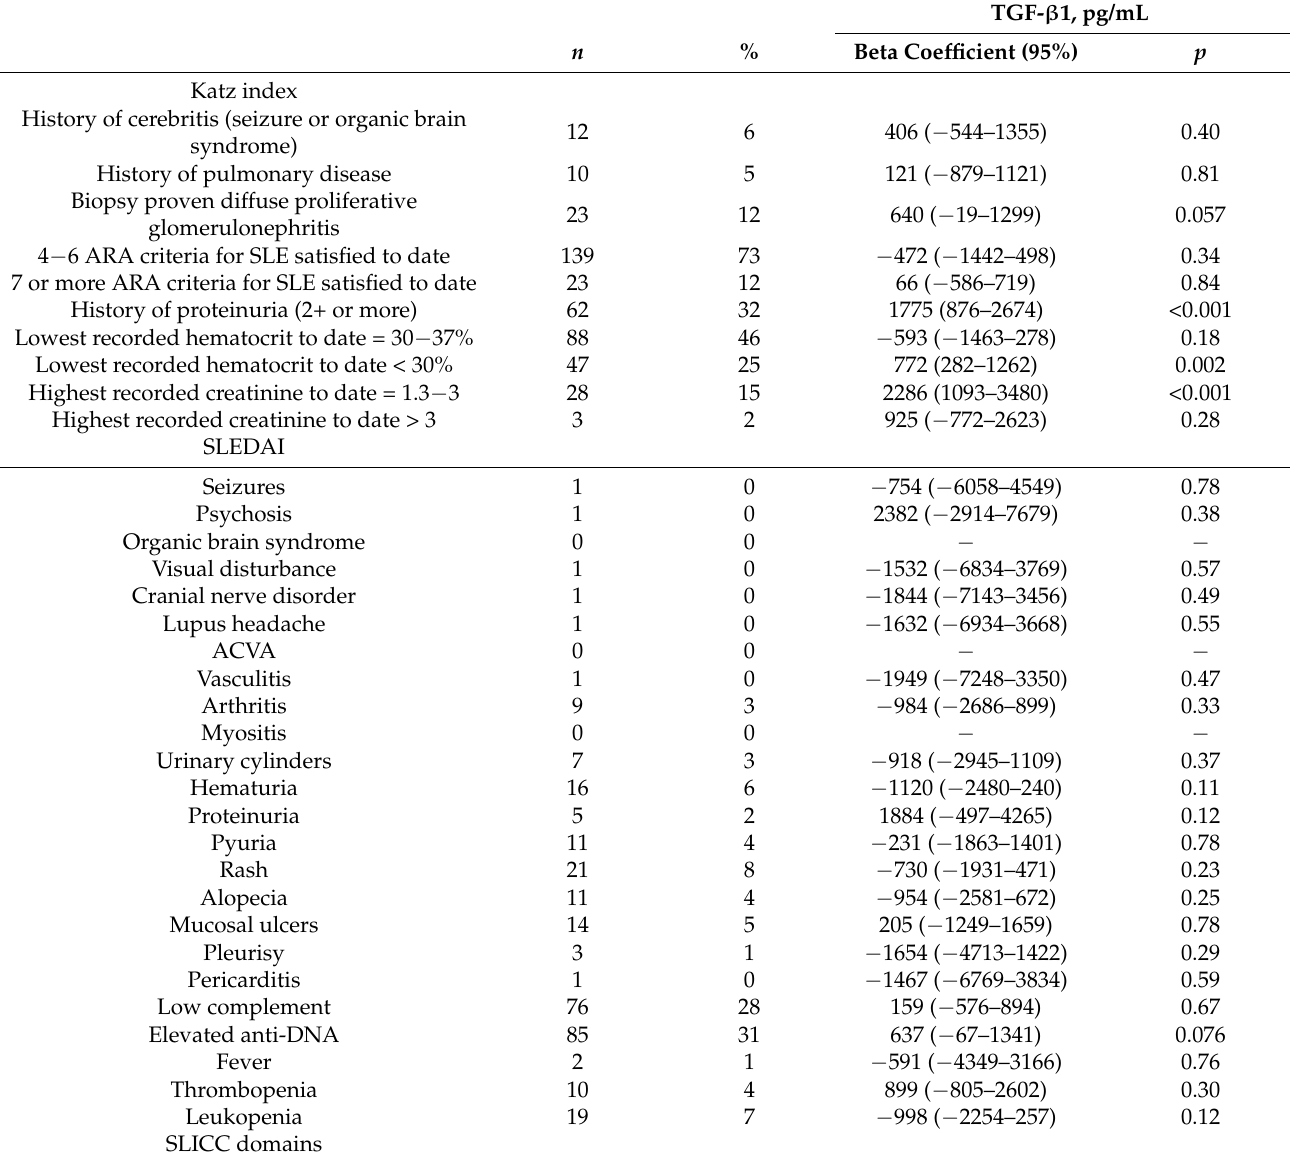
Table 3. Disease score items in relation to the TGF- β 1 serum